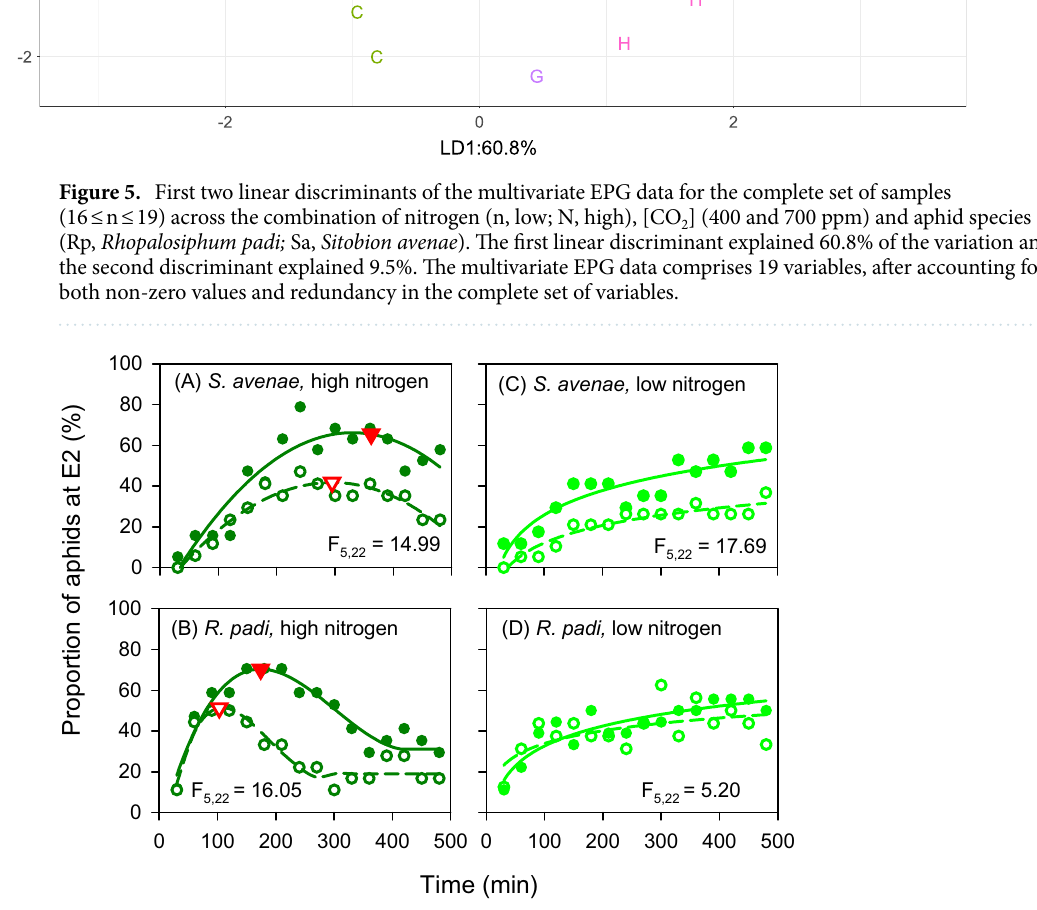
Figure 6. Proportion of aphids passively feeding on phloem sap (waveform E2) as affected by growing conditions of wheat plants in 8-h EPG assays. Open symbols are low [CO 2 ] and closed symbols are high [CO 2 ]. Red arrowheads in ( A , B ) show maxima. Polynomials were fitted to high nitrogen (0.55 < R 2 < 0.90) and logarithmic functions to low nitrogen (0.39 < R 2 < 0.90). An F-test for pair-wise comparison of fitted curves returned p < 0.00001, s > 16.6 for ( A , B , C ) and p = 0.003, s = 8.4 for ( D